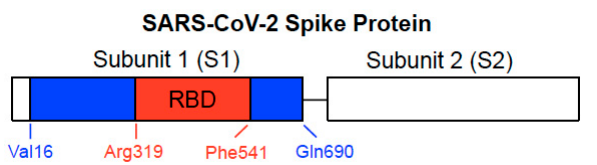
Figure 1. Structure of SARS-CoV-2 spike protein. The spike protein consists of Subunit 1 (S1) and Subunit 2 (S2). The S1 subunit contains the receptor-binding domain (RBD) that binds to ACE2 of the host cell membrane. The S2 subunit is responsible for fusion. In our previous study described in Sections 3 and 5, we used full-length S1 (Val16-Gln690) depicted with blue and red regions and the RBD only-containing protein (Arg319-Phe541) shown in red of the SARS-CoV-2 spike protein (GenBank Accession Number: QHD43416.1).